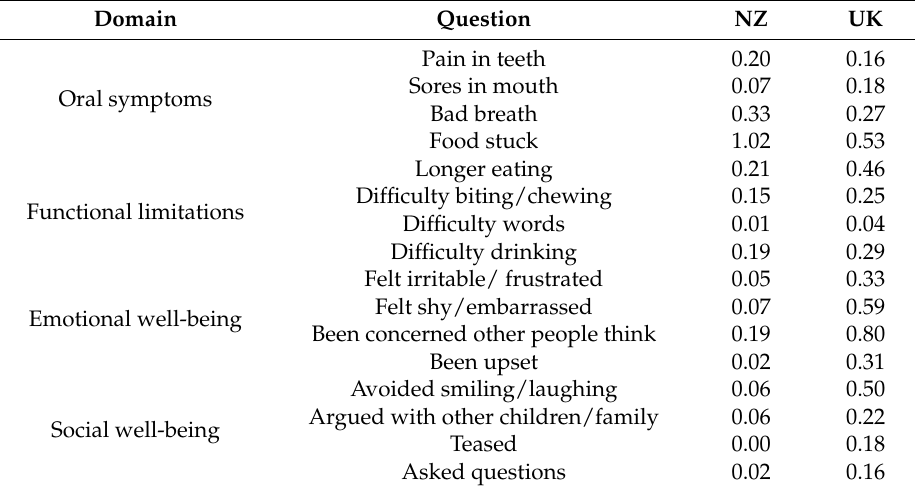
Table 4. Item-impact scores for each CPQ 11-14 -ISF16 question (NZ, n = 64; UK, n = 184).